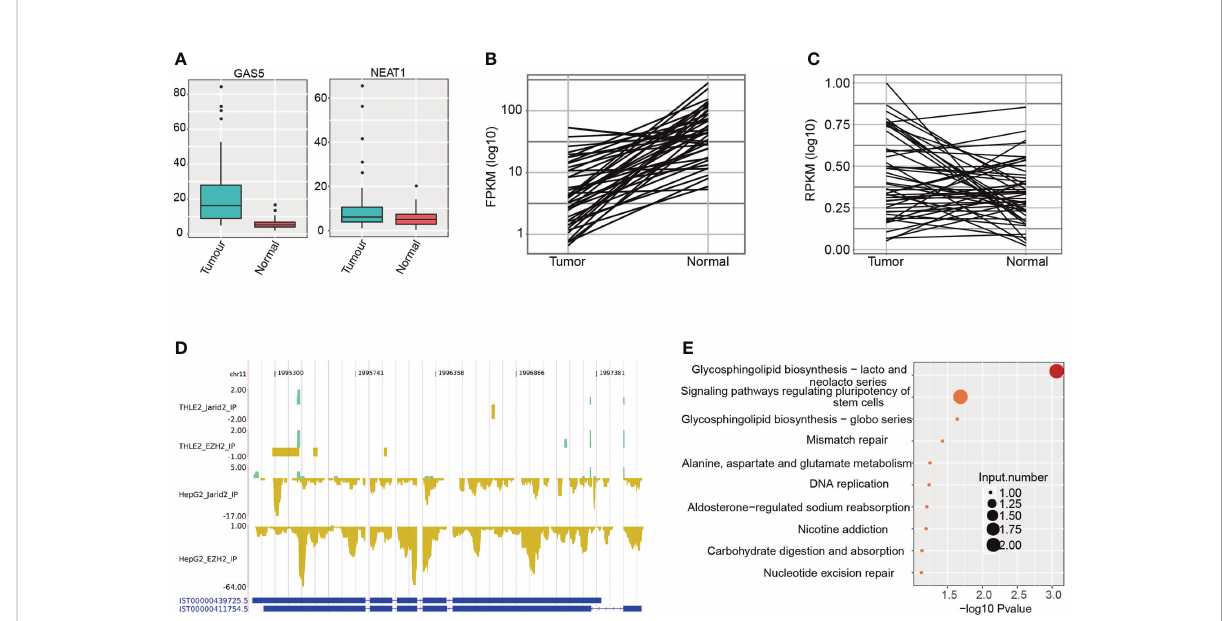
FIGURE 3 Analysis of lncRNAs bound by EZH2 and JARID2 in HepG2 and THLE-2 cell lines. (A) Boxplot showing the expression pattern of two lncRNAs bound by EZH2 and JARID2 in HepG2 and THLE-2 cell lines. The expression levels of lncRNAs were obtained from the TCGA database. (B) Line plot showing the expression pattern of lncRNA H19 bound by EZH2 and JARID2 speci fi c for HepG2 cell line. The expression levels of lncRNAs were obtained from the TCGA database. (C) Line plot showing the expression pattern of lncRNA PDXDC2P bound by EZH2 and JARID2 speci fi c for HepG2 cell line. The expression levels of lncRNAs were obtained from tumor-normal paired HCC samples in the TCGA database. (D) CLIP- seq reads density presentation for lncRNA H19 in the four CLIP-seq datasets. (E) Bubble plot showing the top ten KEGG pathways of the genes co-expressed with